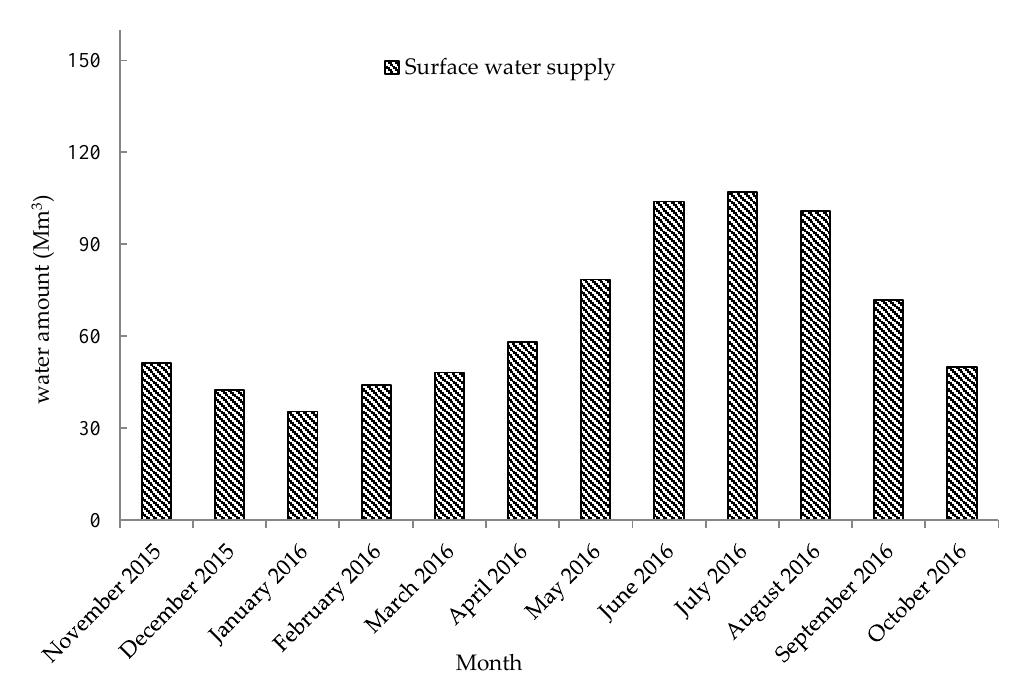
Figure 3. Surface water supply of the Al-Qased canal during the winter season (from November 2015 to May 2016) and summer season (from May to October 2016). Table 4. Water balance in the study area during the winter season (from November 2015 to May 2016).